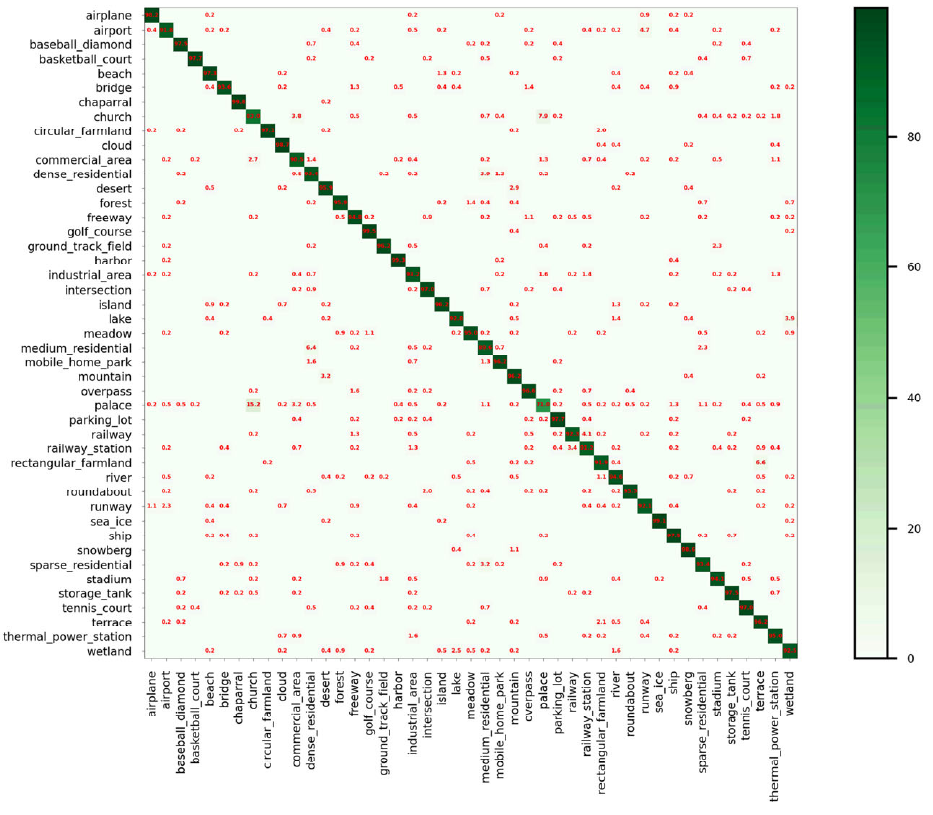
Figure 12. Confusion matrix of F2BRBM on the ground truth NWPU ‐ RESISC45 dataset with a training ration 20%.